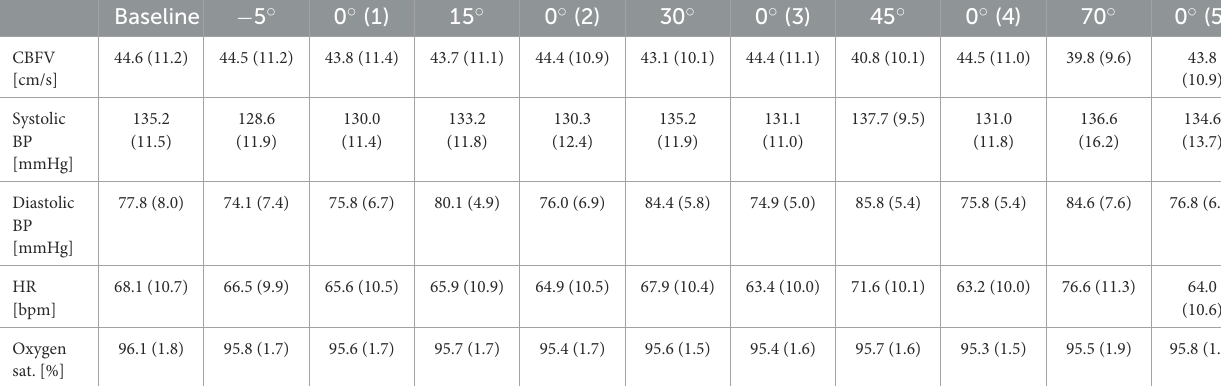
TABLE 2 Mean of clinical parameters during verticalization ( − 5 ◦ to 70 ◦ ) and the pauses (0 ◦ 0.1 to 0 ◦ 0.5).